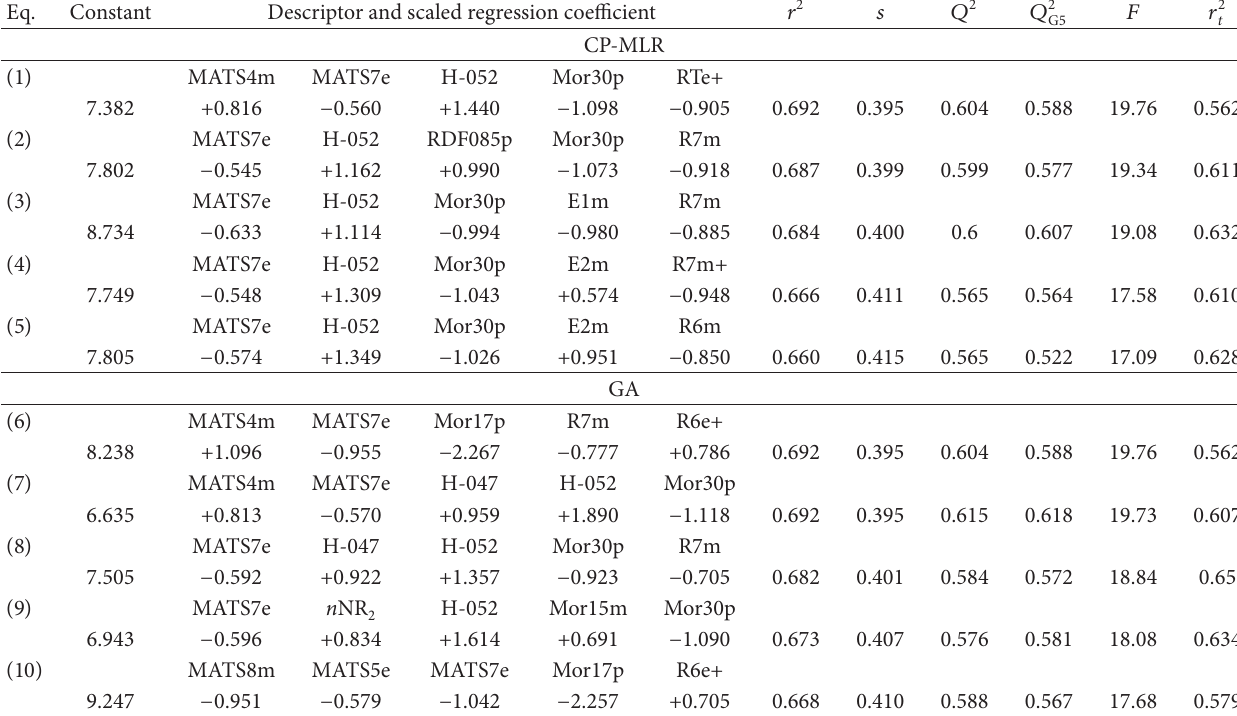
T 3: e CP-MLR and GA �ve-parameter models for antimalarial activity of anilinoquinolines (Table 2) along with statistics a .